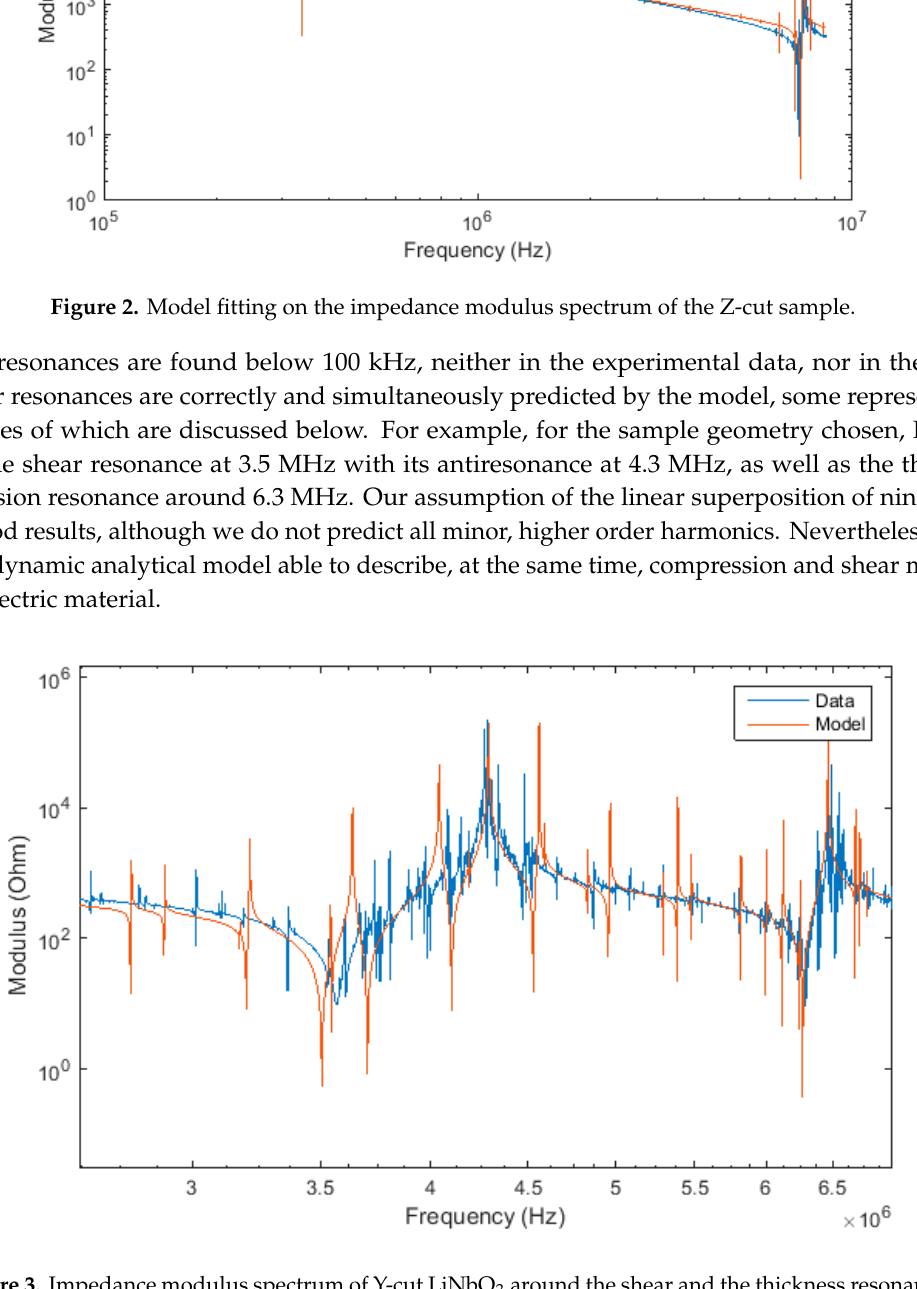
3 around the shear and the thickness